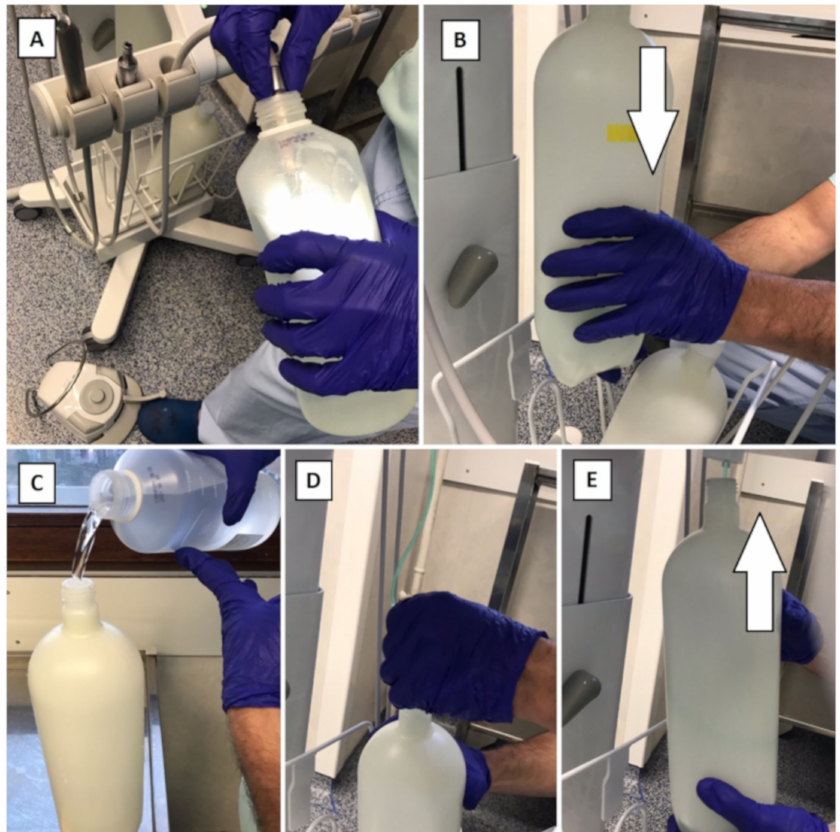
Figure 3. Parts of the maintenance protocol of the mobile dental delivery system (MDDS), before use and between each patient. ( A ) Purge of the air / water spray and the handpieces hoses with the Calbenium © solution; ( B ) removal of the reservoir that contains the Calbenium © solution; ( C ) filling of another reservoir with sterile water; ( D , E ) placement of the reservoir containing sterile